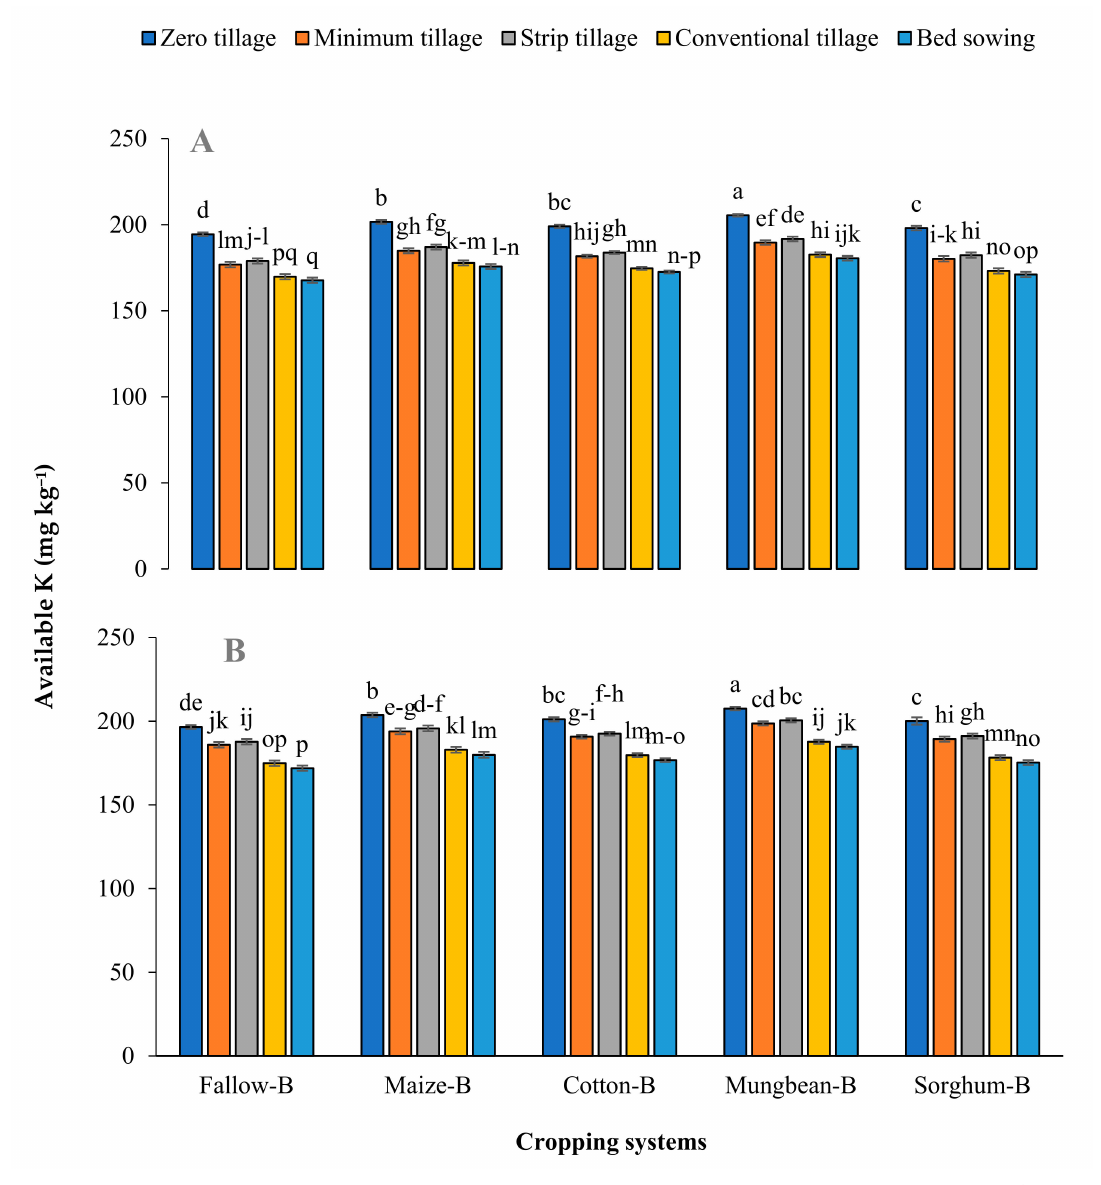
Figure 4. Interactive effect of tillage systems and barley-based cropping systems on soil available K (mg kg − 1 ) after barley harvest during 2017–2018 ( A ) and 2018–2019 ( B ) ± S.E. In the legend, Fallow-B = Fallow-barley, Maize-B = Maize-barley, Cotton-B = Cotton-barley, Mungbean-B = Mungbean-barley and Sorghum-B = Sorghum-barley. The means sharing same letters do not differ significantly ( p > 0.05). LSD 0.05 (2017–2018 = 3.18, 2018–2019 =